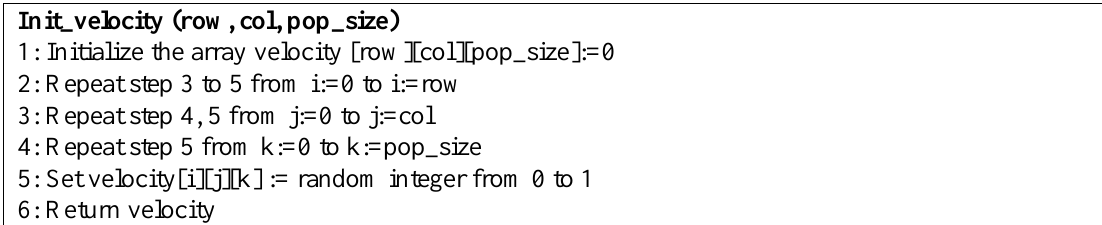
Algorithm 2 is used to calculate the particle’s fitness value using equations (11) and (12). It measures the average distance of gray value of each pixel from the centroid of the segment. Algorithm 3. Function to initialize the